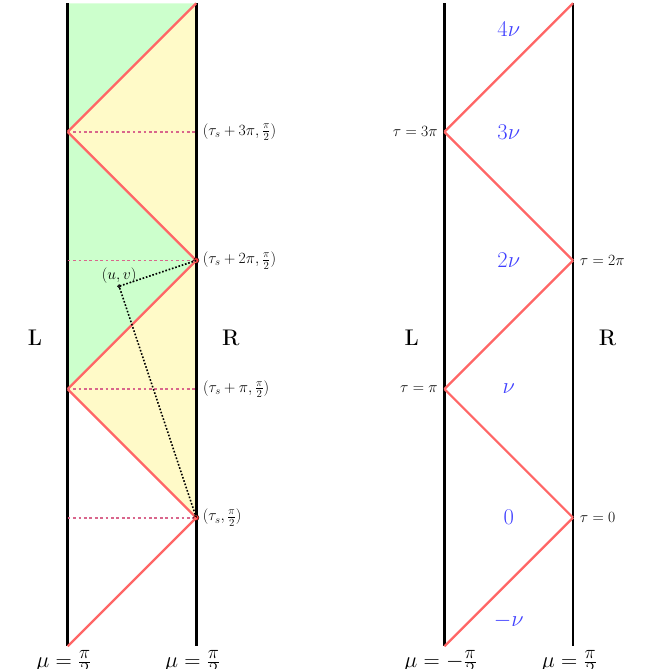
Figure 1 . On the left, the evaluation point ( u; v ) should be timelike separated from the source point ( (cid:28) s ; (cid:25) ), while the naive 2 (cid:25) periodicity implies that it is spacelike separated from the source. 2 On the right, the phase assignment for K (cid:3) is given where (cid:23) = (cid:25) (cid:1) with (cid:28) s = 0. R only when (cid:28) > (cid:28) + (cid:25) and the corresponding propagation respects bulk causality. Here, s